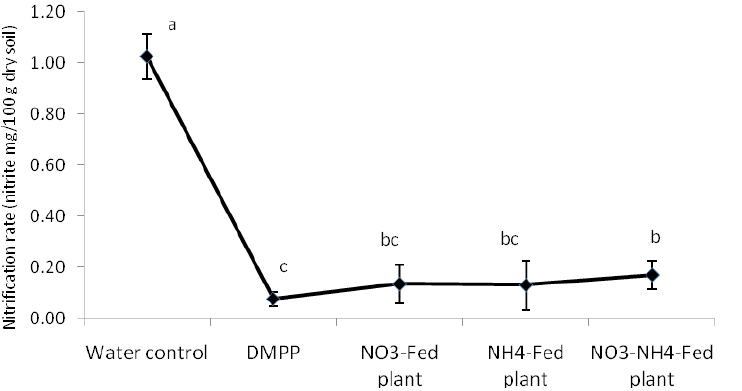
Fig. 4. Mean value of nitrite produced by application of 0.5 g fresh shoot homogenates from B. humidicola during 50 hour incubation period. Plants were grown with 2 mM N as ammonium sulphate, calcium nitrate, or ammonium nitrate. DMPP was used with a concentration of 10 times of normal concentration (1% of N-NH ). Data are averages of four replicates ± SD 4